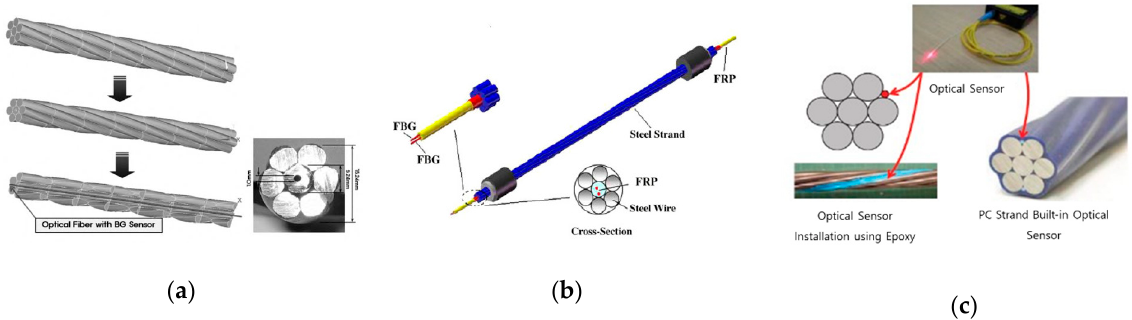
Figure 2. Research on prestressed concrete (PC) strands with measurable prestressing force: ( a ) fiber Bragg grating (FBG) sensors encapsulated into seven-wire steel strand by Kim et al. [3]; ( b ) Smart steel strand by Zhou et al. [4]; ( c ) Optical fiber-embedded strand by Imai et al. [5].